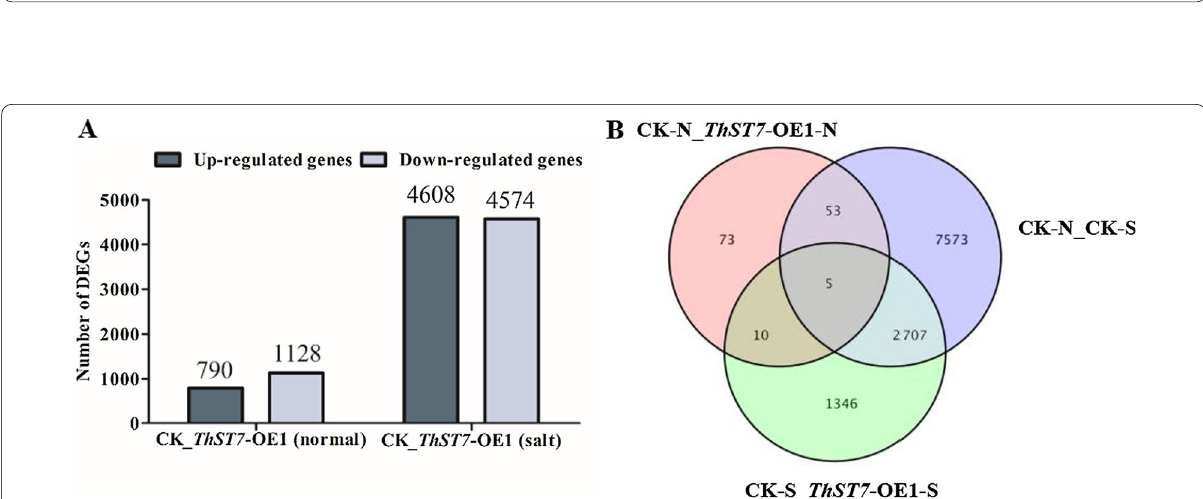
Fig. 5 RNA-seq of the CK and ST7 -OE seedlings under normal and salt stress conditions. A Number of upregulated and downregulated genes in CK and ST7 -OE under normal and salt stress condition as revealed by RNA sequencing. B Venn diagrams of the common and specific genes unique and shared between the different pairwise